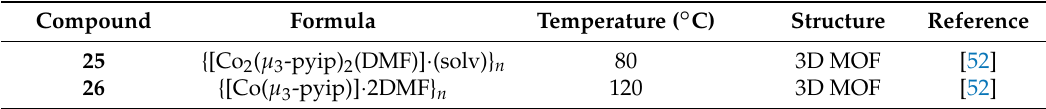
Table 4. Selected examples of CPs showing an effect of reaction temperature on product structure. Compound